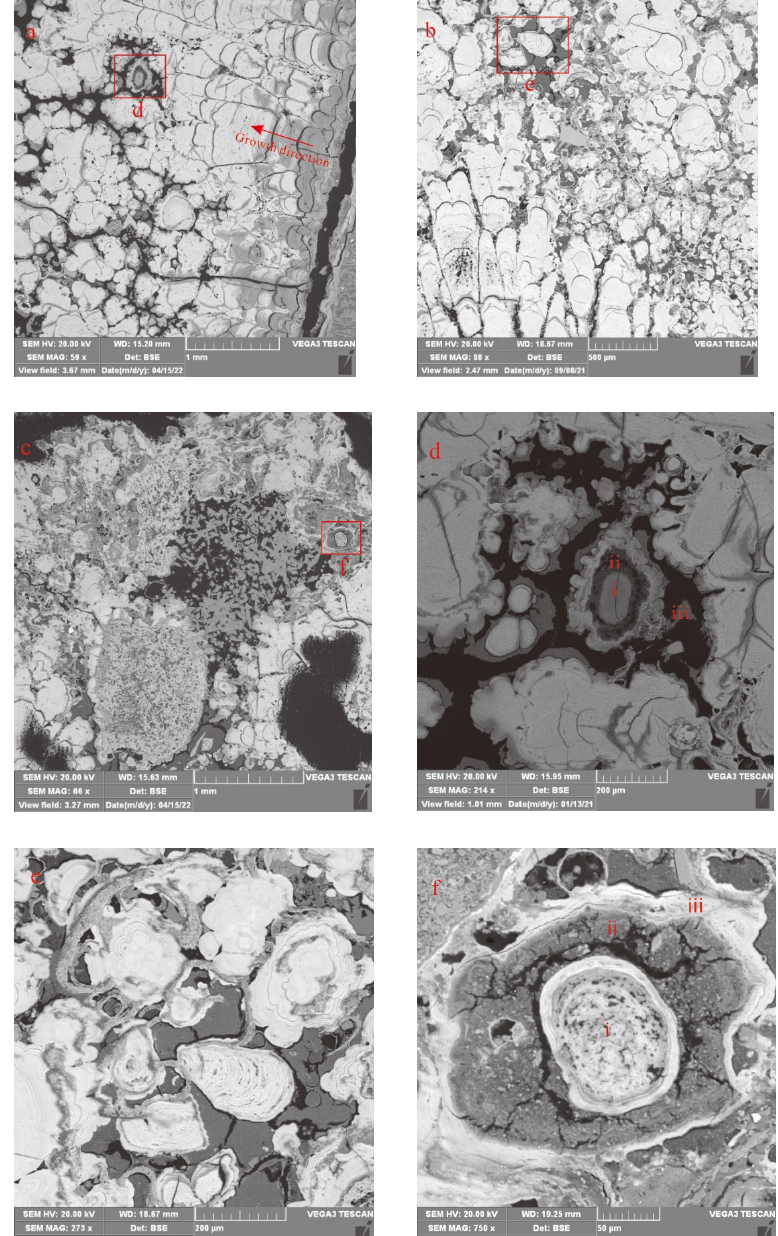
Figure 4. ( a ) Columnar structure composed of upright columns along the growth direction at the junction of the nucleus and ferromanganese oxides; ( b ) columnar structure gradually transit to mottled structure in stage II; ( c ) mottled structure composed of siliceous debris and Mn-rich oxides in stage II; ( d ) groups in gaps between columns in Figure 4a,i. Mn-rich oxides, ii. Ca-carbonate, iii. Si-Fe-rich cement; ( e ) Mn-rich oxides connected by banded Si-Fe-rich cement in Figure 4b; ( f ) groups in gaps between columns in Figure 4c,i. Mn-rich oxides, ii. organic matter where Mn- rich oxides scatter; iii. Si-Fe-rich